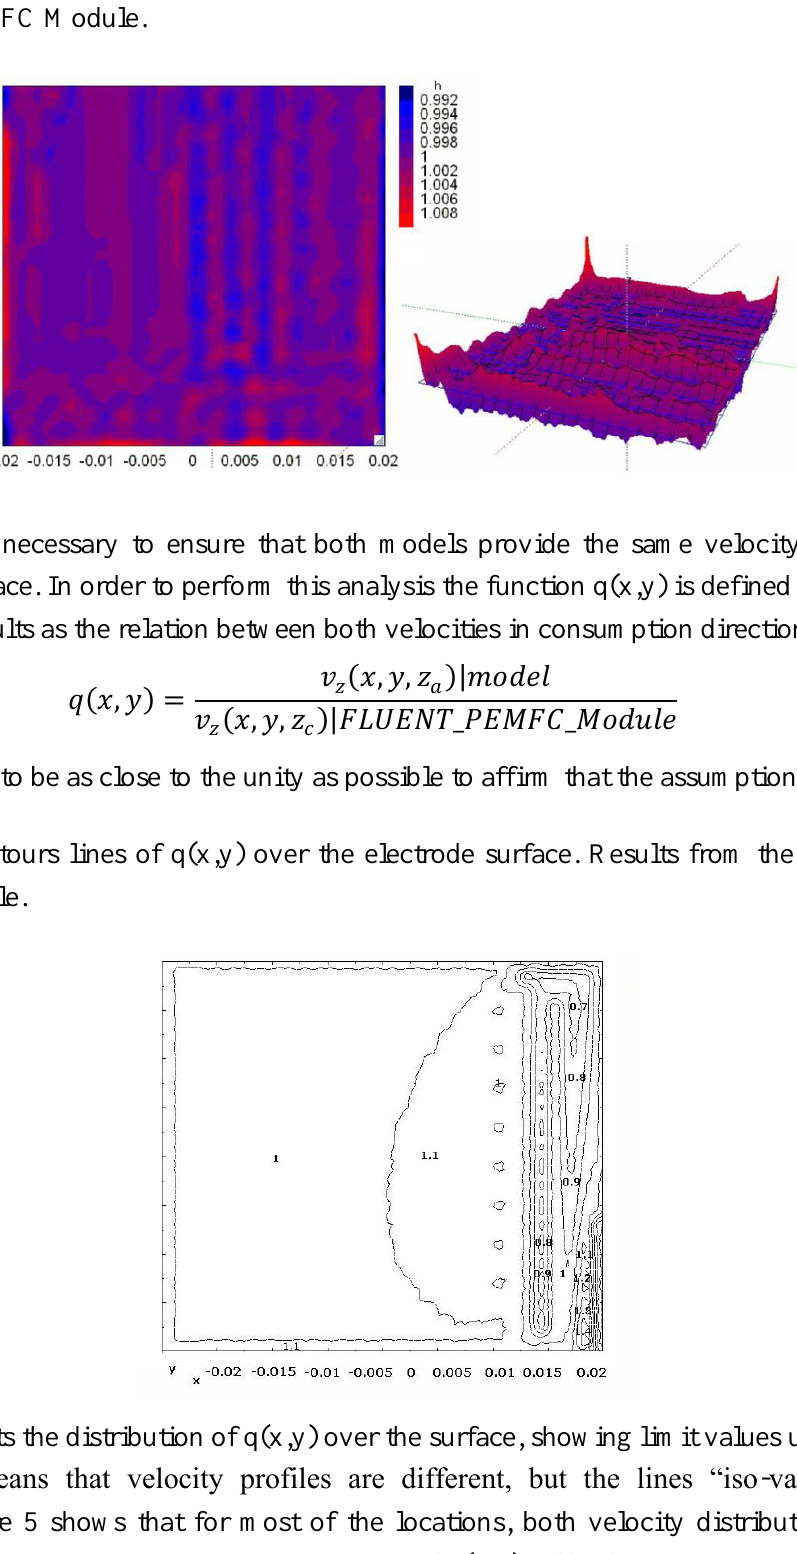
Figure 4. Distribution of h(x,y) over the anode electrode surface. Results from the FLUENT PEMFC Module.